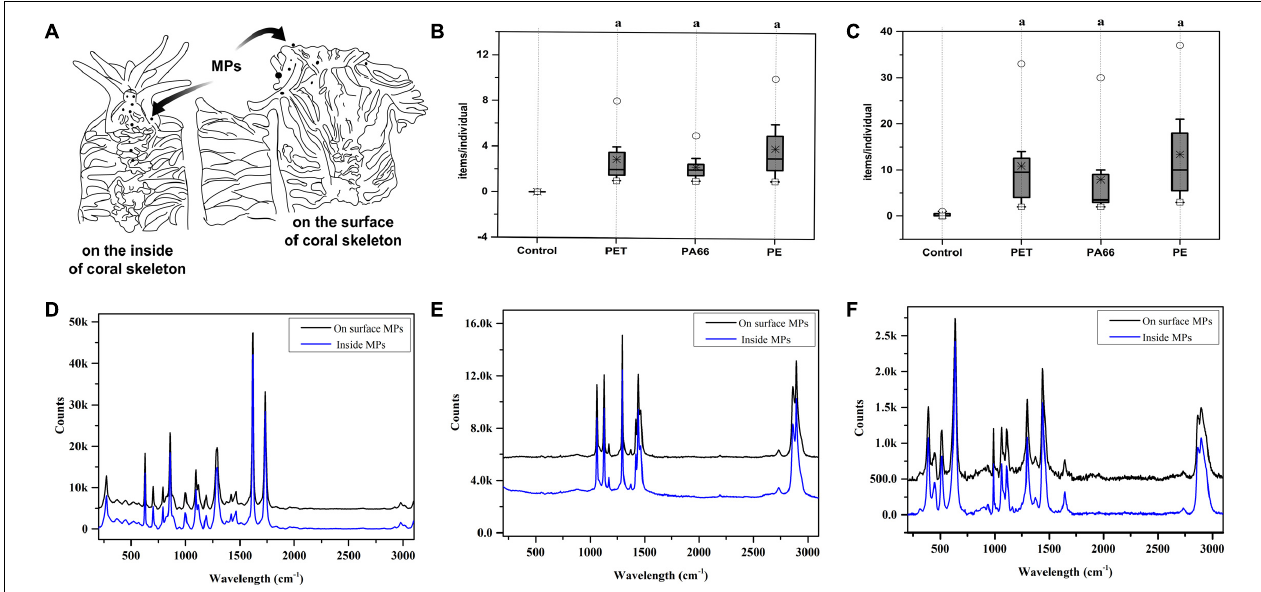
FIGURE 1 | Plastic ingestion and Raman spectroscopy identification of microplastics structures in corals. The diagram of coral skeleton (A) . The MPs content on the inside of the skeleton (B) and on the surface of the coral skeleton (C) respectively. (cid:13) , *, and represent the maximum value, median value, and minimum value. Values are means ± SD, N > 3. Parts a represent significantly different groups (Wilcoxon test, p < 0.05). MPs identified by Raman spectroscopy on the surface of (cid:50) the skeleton and inside, and the results are presented respectively. (D) PET, (E) PE, and (F) PA66.